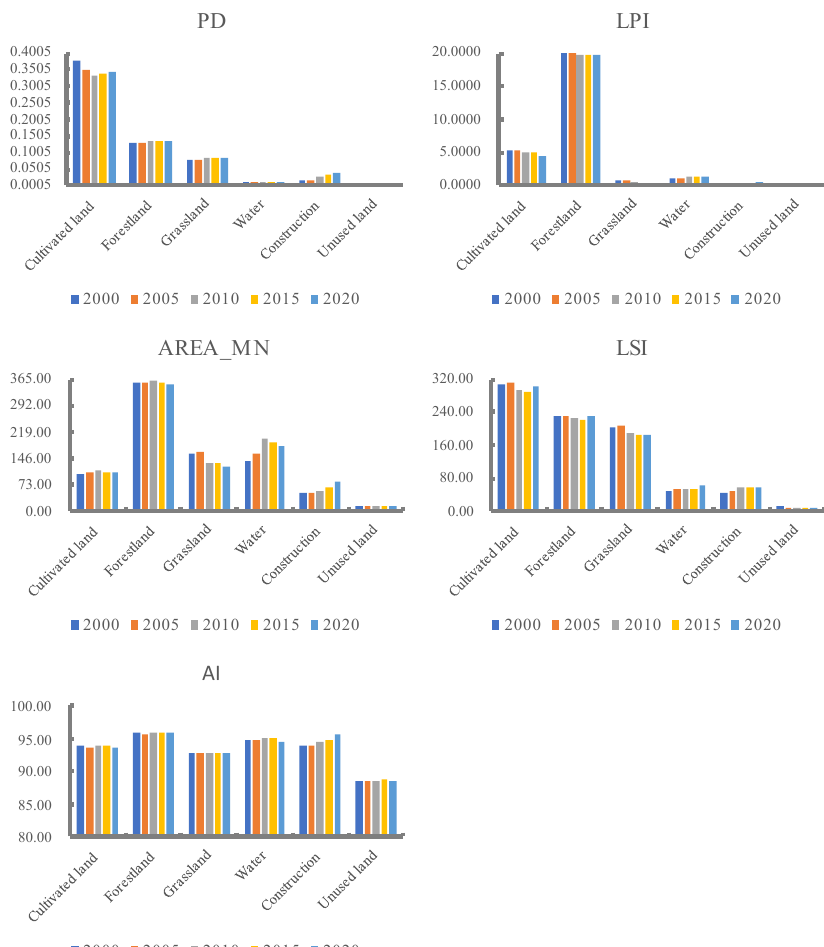
Figure 4. Index change of landscape pattern at class level.